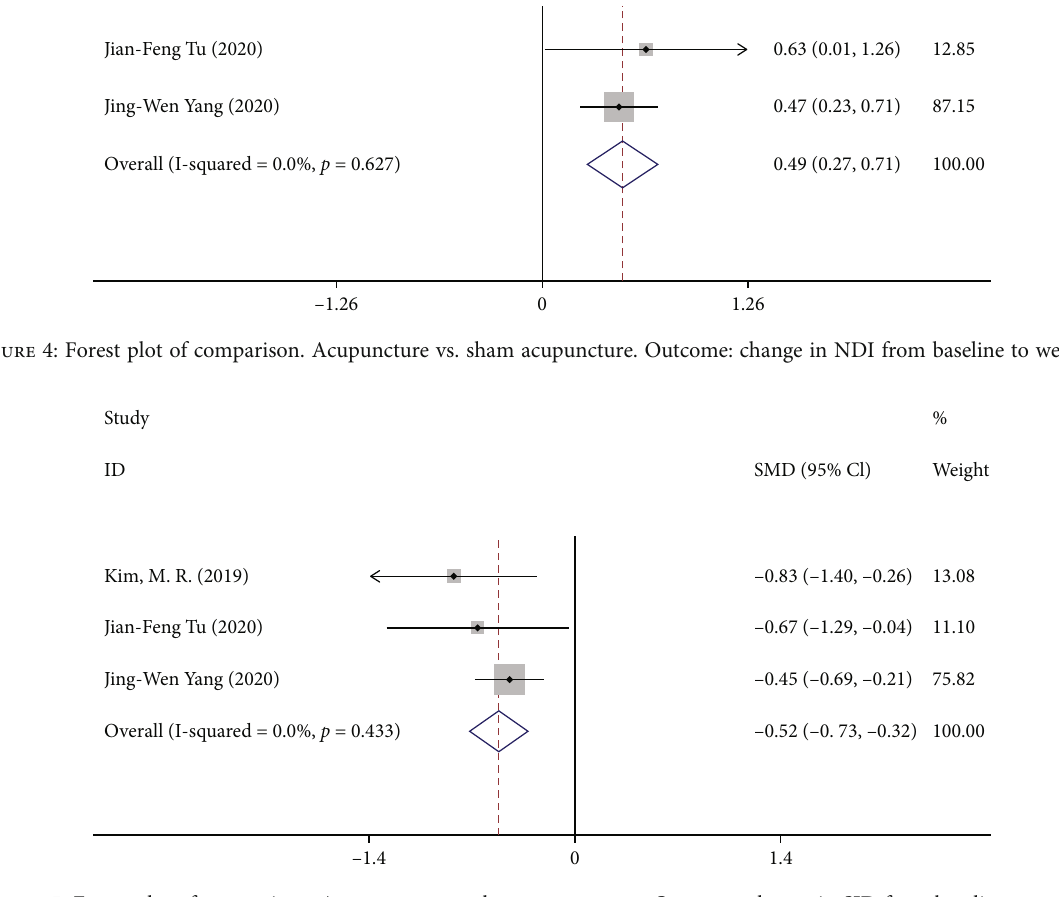
Figure 5: Forest plot of comparison. Acupuncture vs. sham acupuncture. Outcome: change in SID from baseline to week